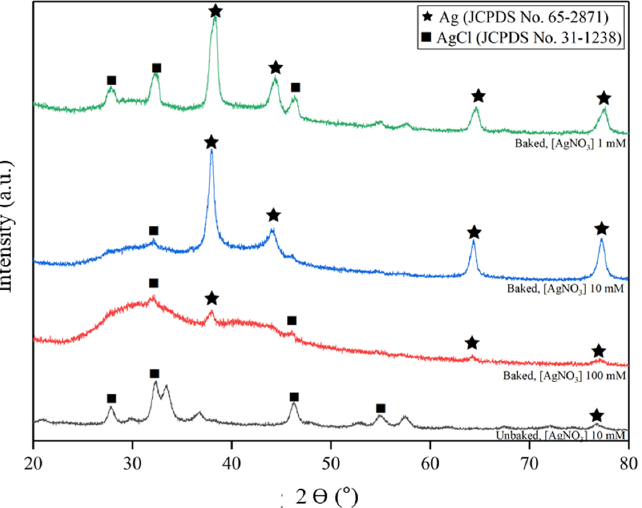
Figure 3. XRD patterns of samples powder prepared at various extract type and AgNO 3 concentration.